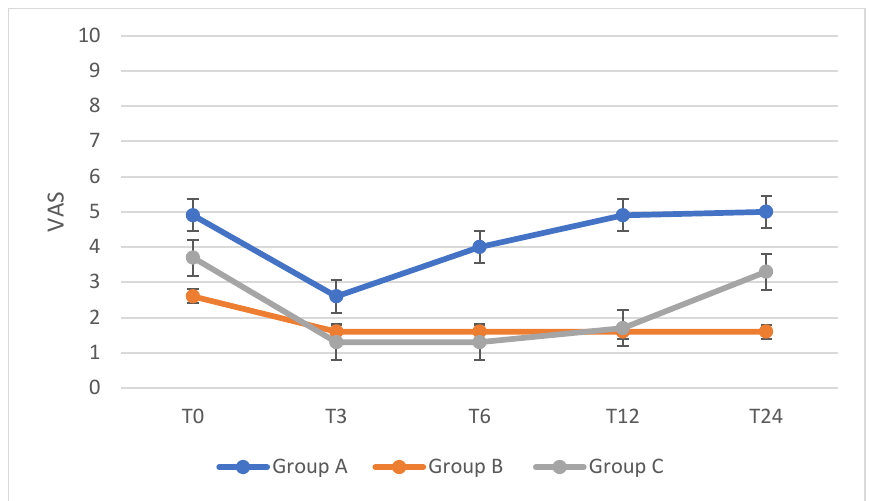
Figure 2. Changes of CPP VAS score over time in exclusively breastfeeding women compared to the months of breastfeeding. T0 = before pregnancy; T3 = 3-month follow-up; T6= 6-month follow-up; T12 = 12-month follow-up; T24 = 24-month follow-up. A = 1–2 months of breastfeeding; B = 3–5 months of breastfeeding; C = 6–8 months of breastfeeding.